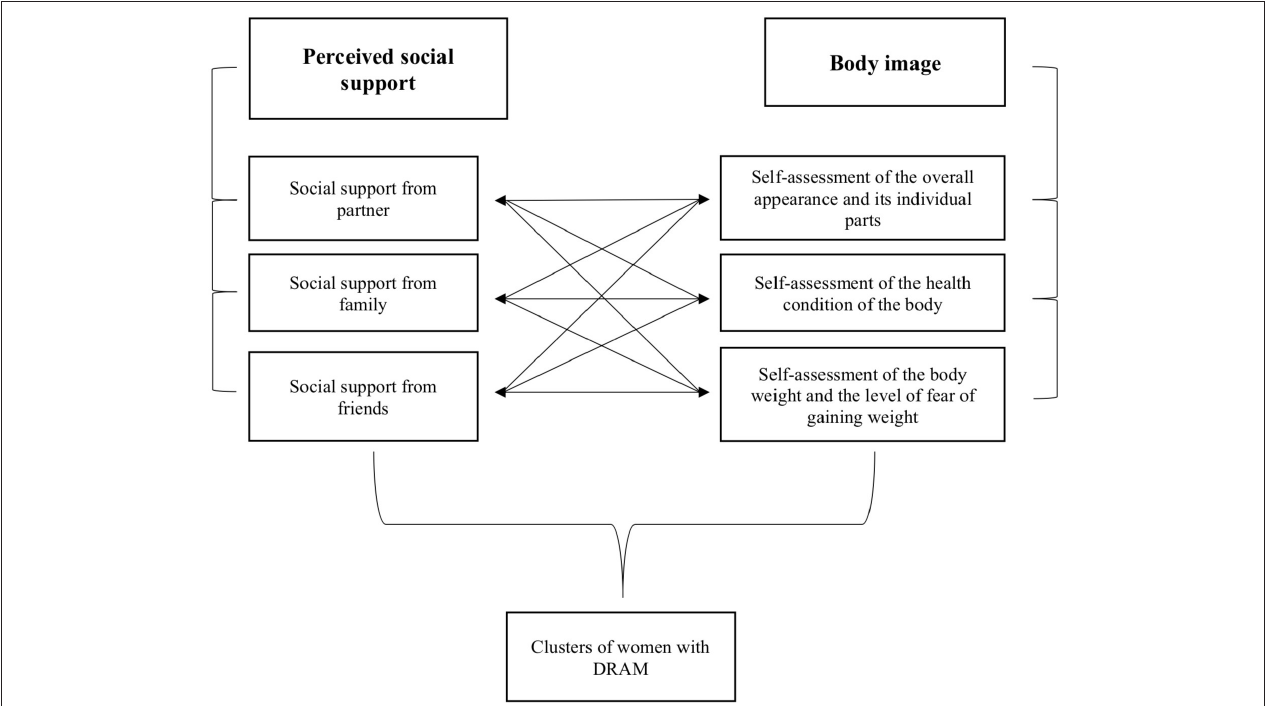
FIGURE 1 | Research model of the